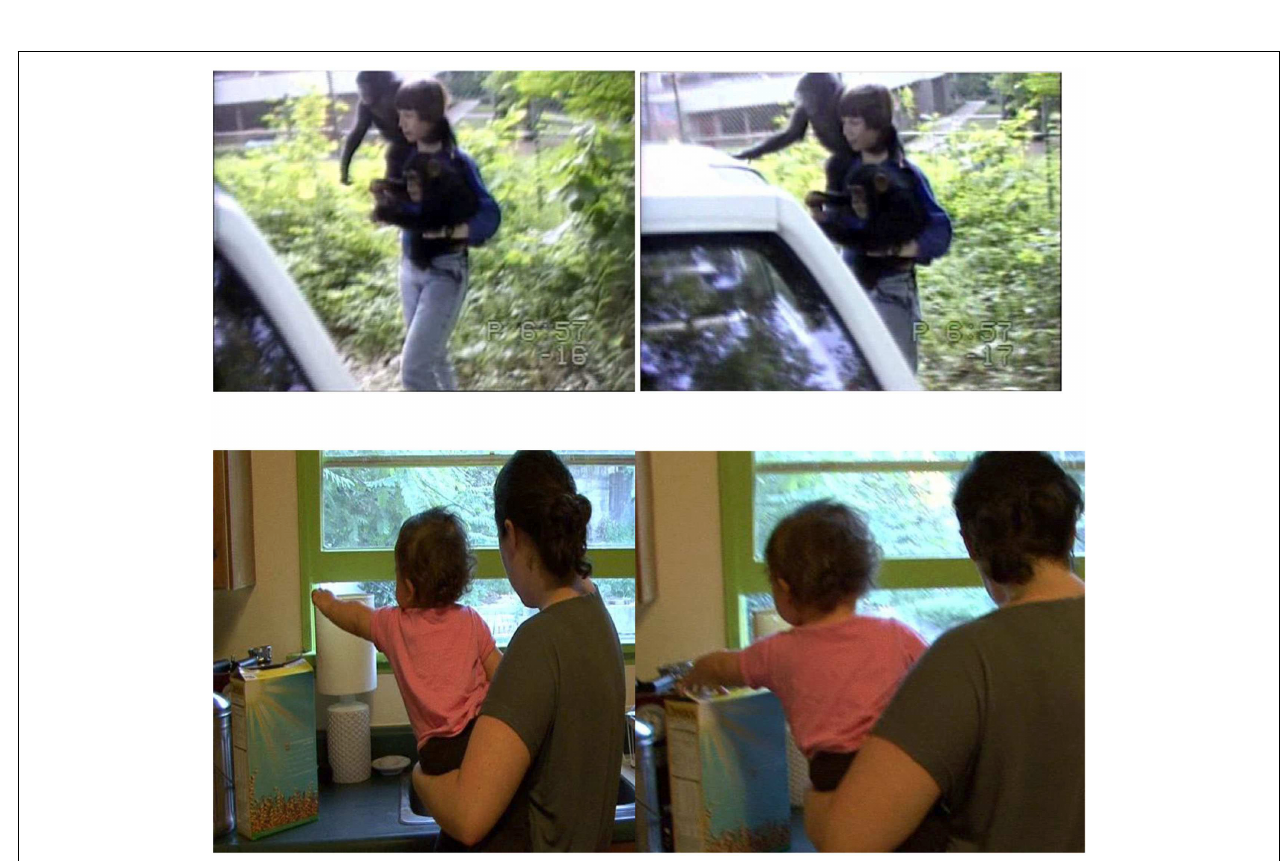
Then as they near car, Panbanisha (17months, 26days) gestures to it and Sue walks toward it till they can touch it. “Oh you wanted to go in Steve’s car,” she says, and they peer inside. Bottom: human example – Mom is holding GN (11months, 7days) and washing something in the sink. GN reaches toward Cheerios. Mom walks closer so GN can reach into box and get